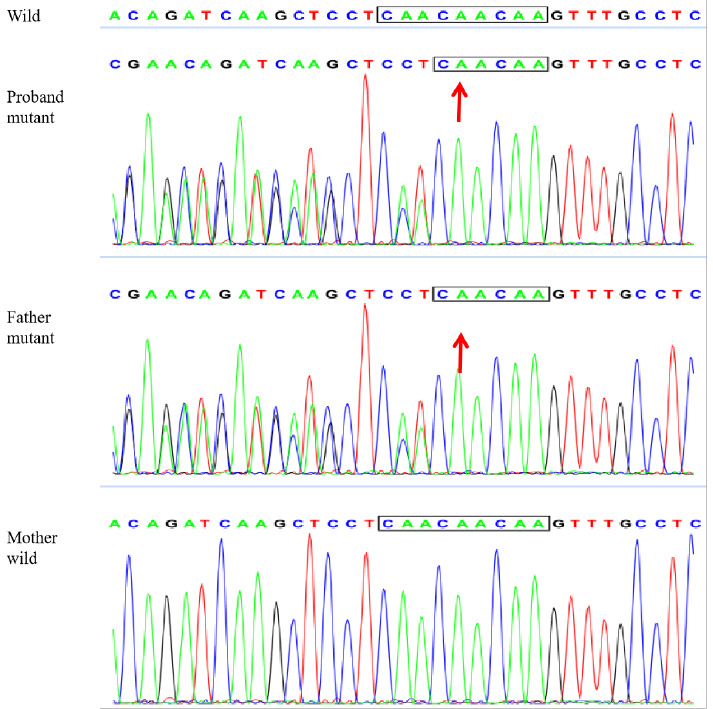
Figure 7. Gene sequencing results showing the heterozygous deletion (C. 438_440delCAA) in exon 1 of the K4 gene in the proband and his father, namely the aspartic acid loss, and no abnormality in the mother, with the arrows indicating the missing bases.